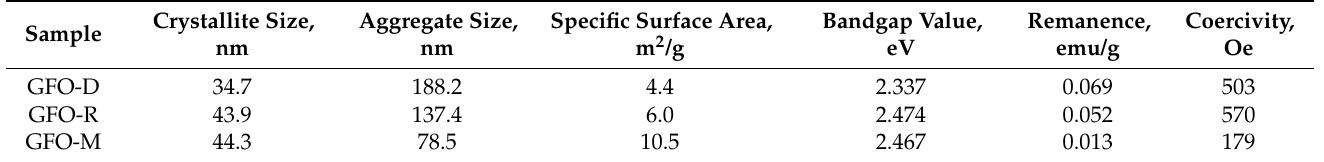
Table 3. Summarized characteristics of the GdFeO 3 nanoparticles synthesized using different co-precipitation techniques. Crystallite Size, Sample GFO-D